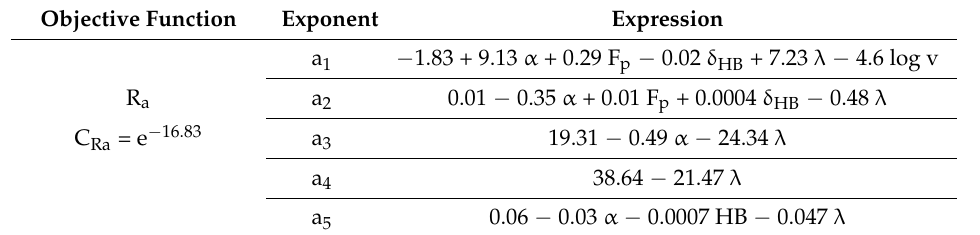
Table 2. Expression of the objective function